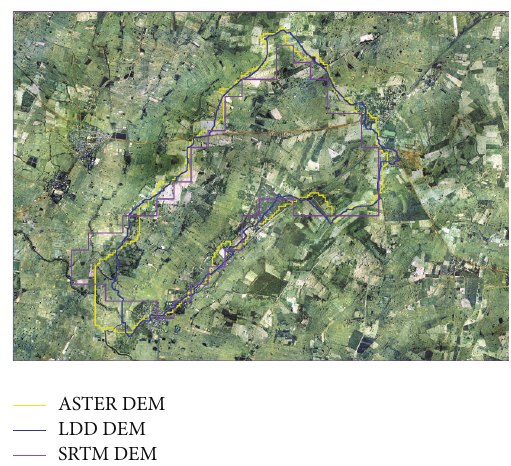
Figure 3: Watershed delineation for Huai-Por-Phan watershed.